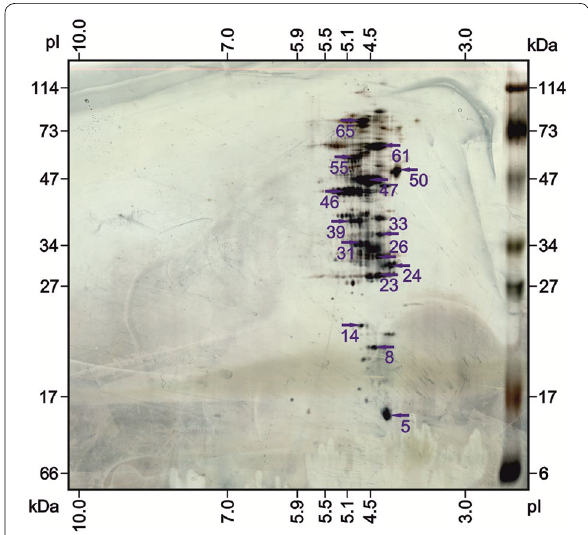
Fig. 5 The Protein profiles of spots chosen for MALDI‑TOF identification obtained from phages specific for M. haemolytica strains